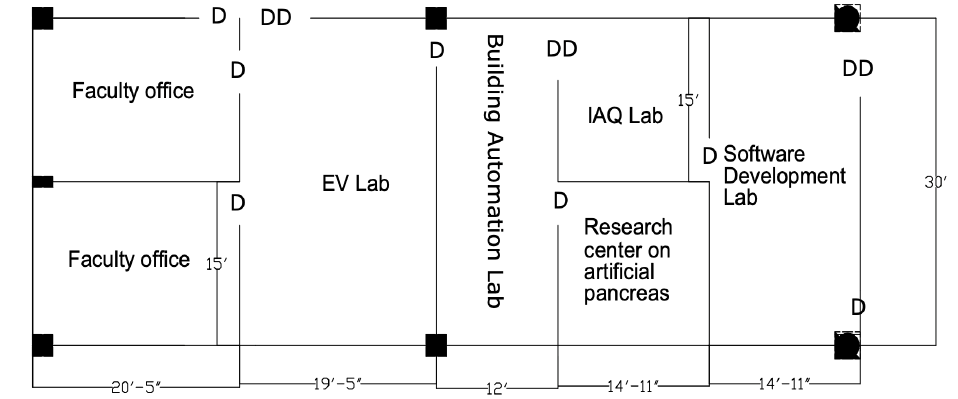
Figure 1. C-RACE laboratory layout located at Kalasalingam University, India (D–Door, DD–Double